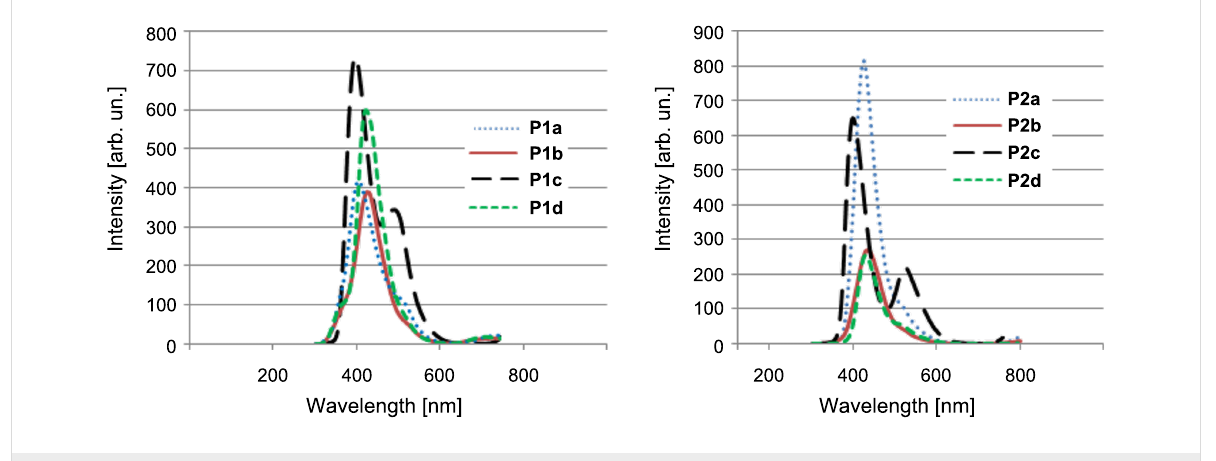
Figure 7: Photoluminescence spectra of polymers P1 and P2 in CHCl 3 solution.